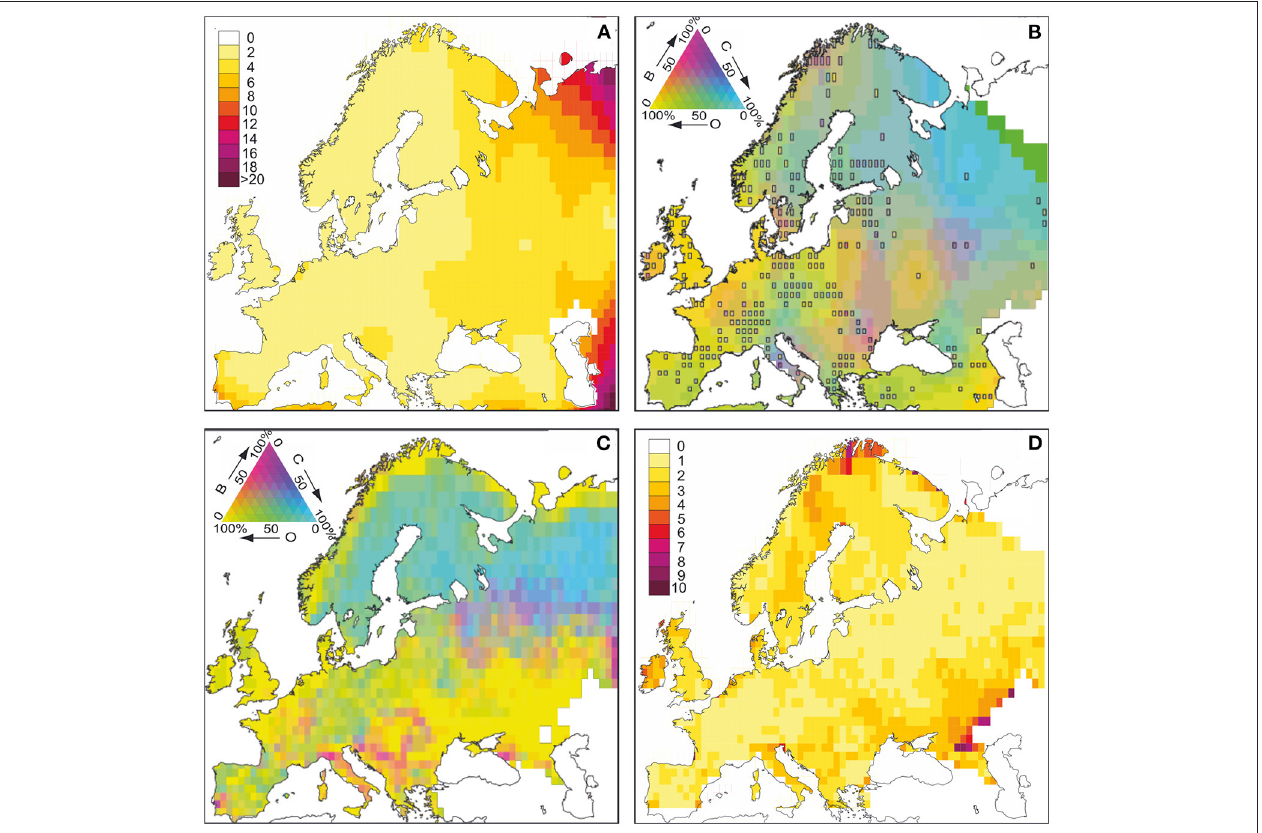
FIGURE 3 | Validation datasets of major land-cover types (LCTs: B, broad-leaved forest; C, coniferous forest; O, open land), area of confidence region (CR) and compositional distance (CD) estimates. (A) CR (100 BP–present): area of confidence regions for 100 BP–present time-window (smaller values are better, see Figure 2 for examples of CRs); (B) 100 BP–present: reconstructed proportions of LCTs in Europe for the most recent time window; (C) EFI-FM: observed modern LCT proportions according to the European forest institute forest map ( Päivinen et al., 2001); (D) compositional distance (EFI-FM vs. 100 BP–present): composition distance between EFI-FM and 100 BP–present